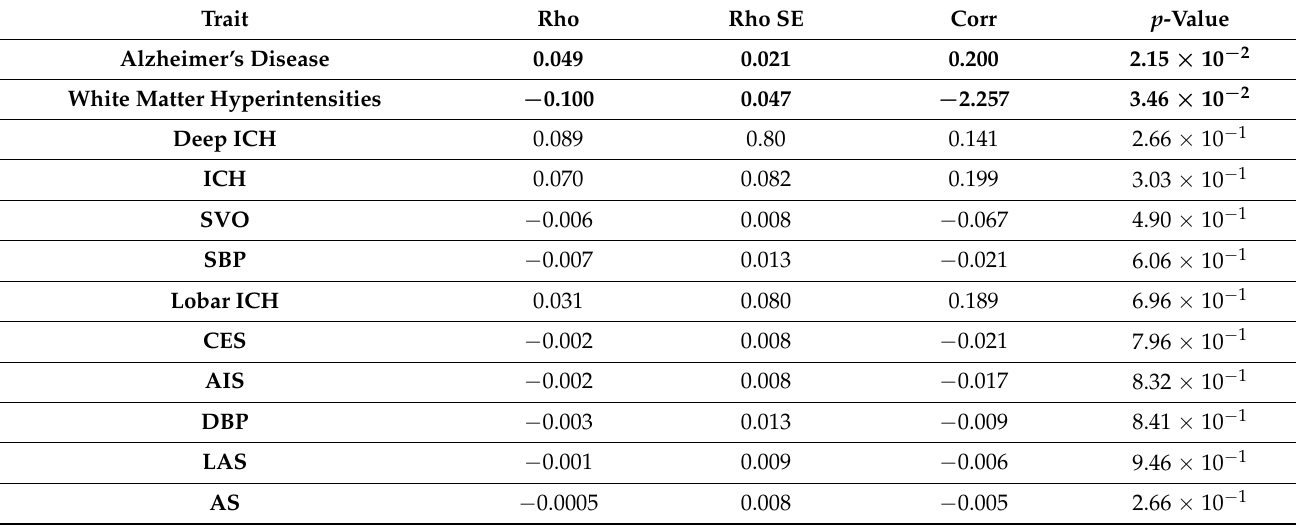
Table 6. Results of the genetic correlation